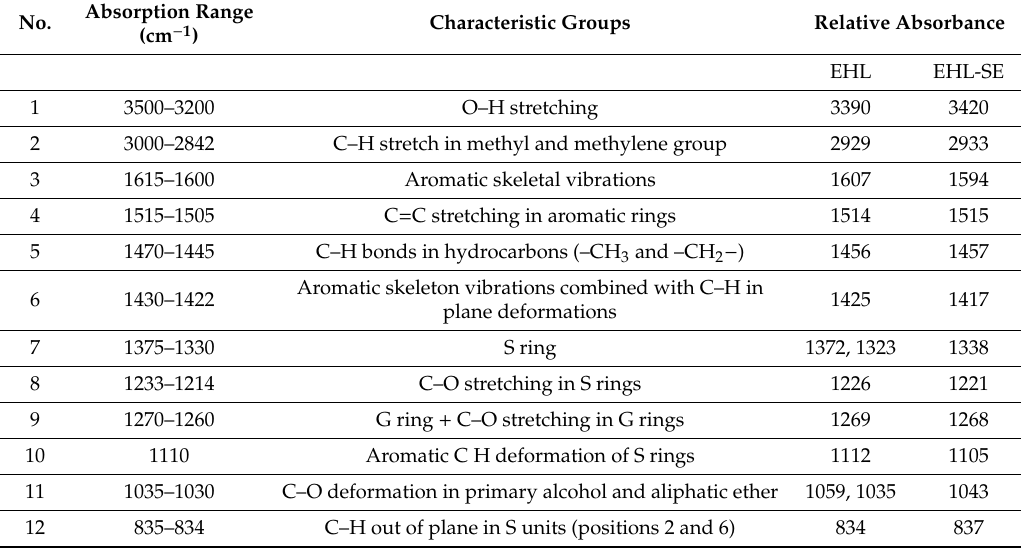
Table 1. Specific FT-IR spectral of EHL and